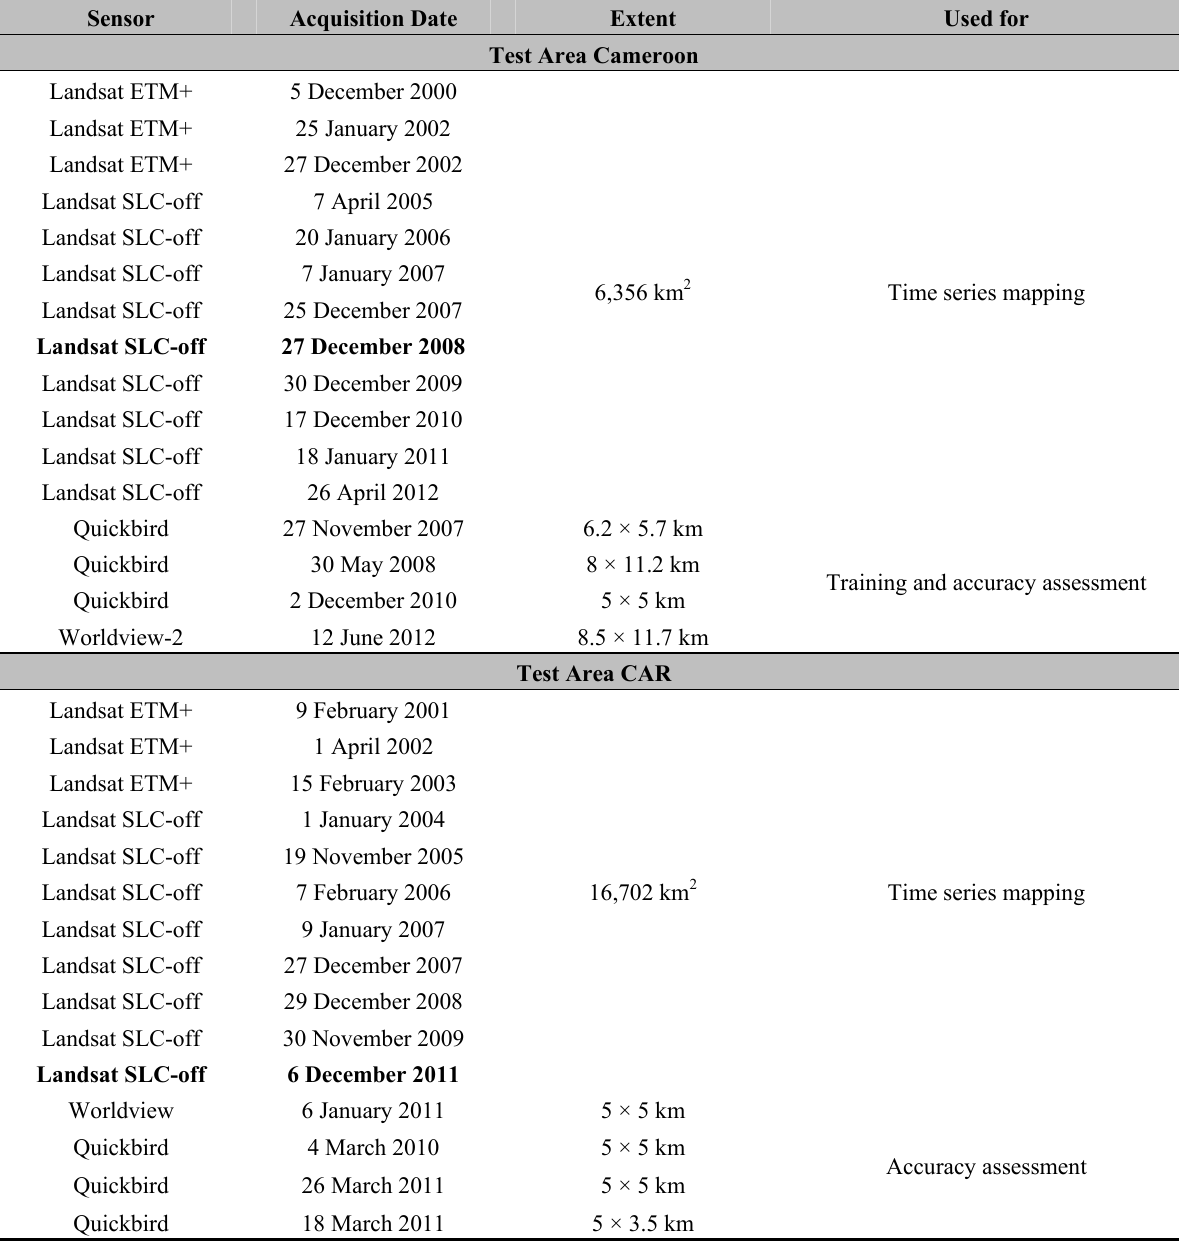
Table 1. Imagery used for the two study sites in Cameroon and Central African Republic (CAR).